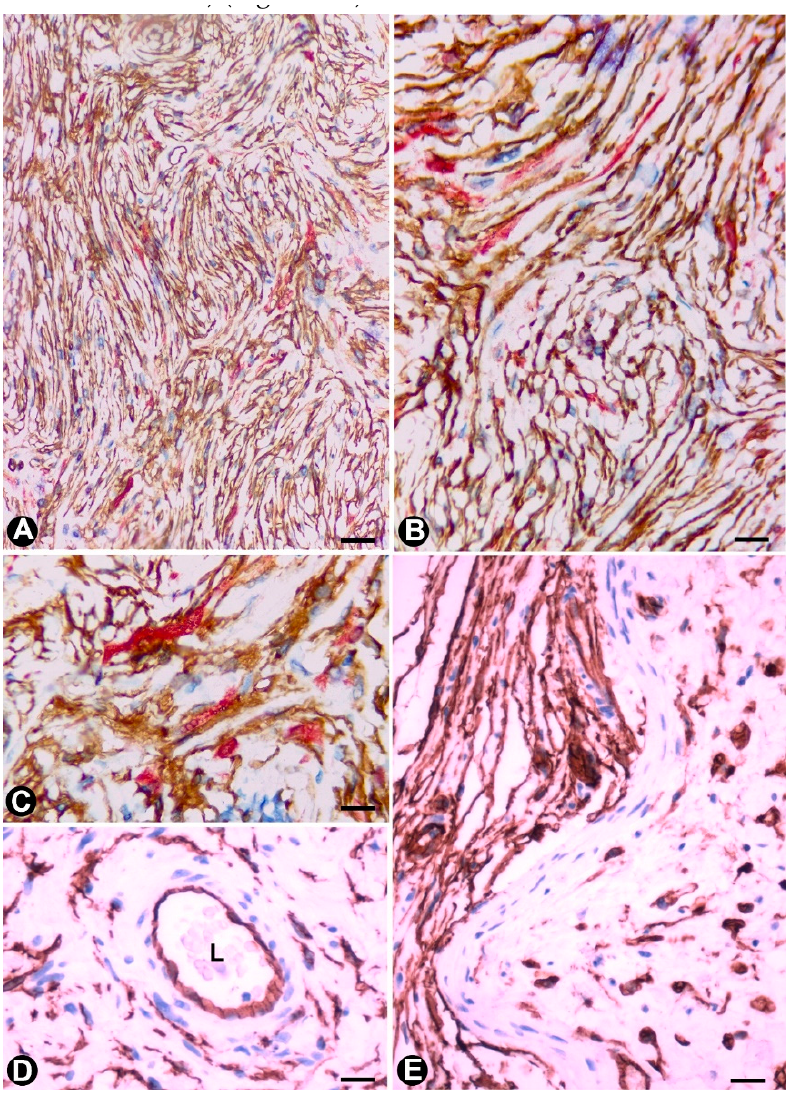
Figure 6. TCs/CD34+SCs in neurofibromas. ( A – C ) Using double-immunostaining (anti-CD34 and anti-S100), numerous TCs/CD34+SCs (brown), intermixed with Schwann cells (red) are observed forming bundles with parallel, arciform or irregular arrangement. ( D ) TCs/CD34+SCs are also seen in the adventitia of blood vessels in the tumour. ( E ) CD34+ cells (ameboid dendritic cells) in a myxoid area of a plexiform neurofibroma. D and E: Immunostained with anti-CD34. Bar: A, 80 µm; B, D, 60 µm; C, 20 µm; E, 40 µm.